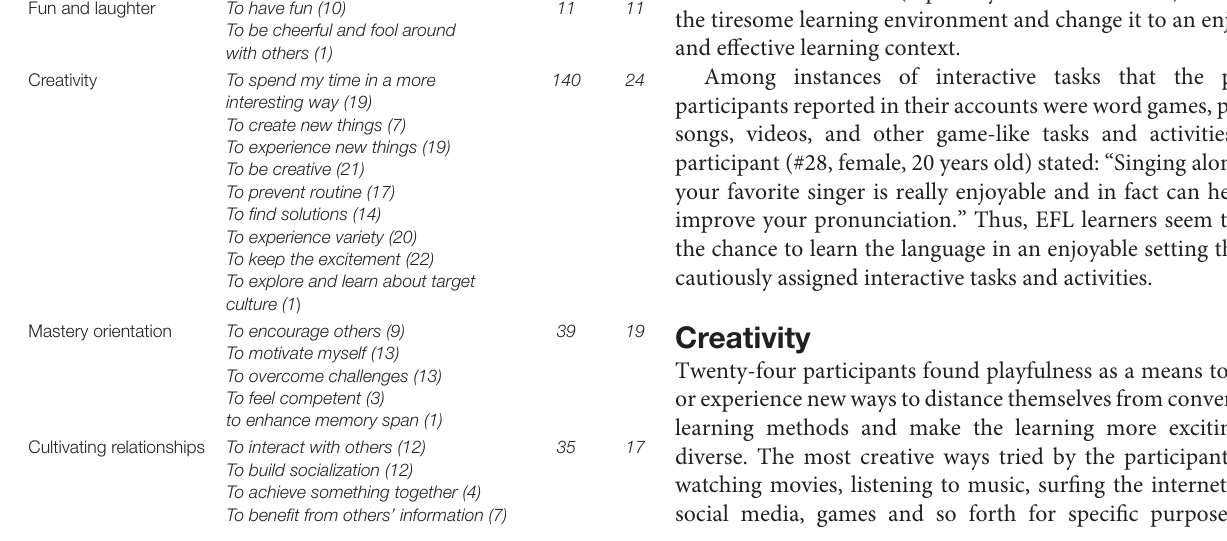
TABLE 1 | Distribution of perceived functions of playfulness in an EFL classroom. Functions categories Area: EFL